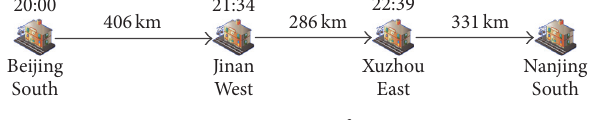
Figure 1: Route map of train G205.